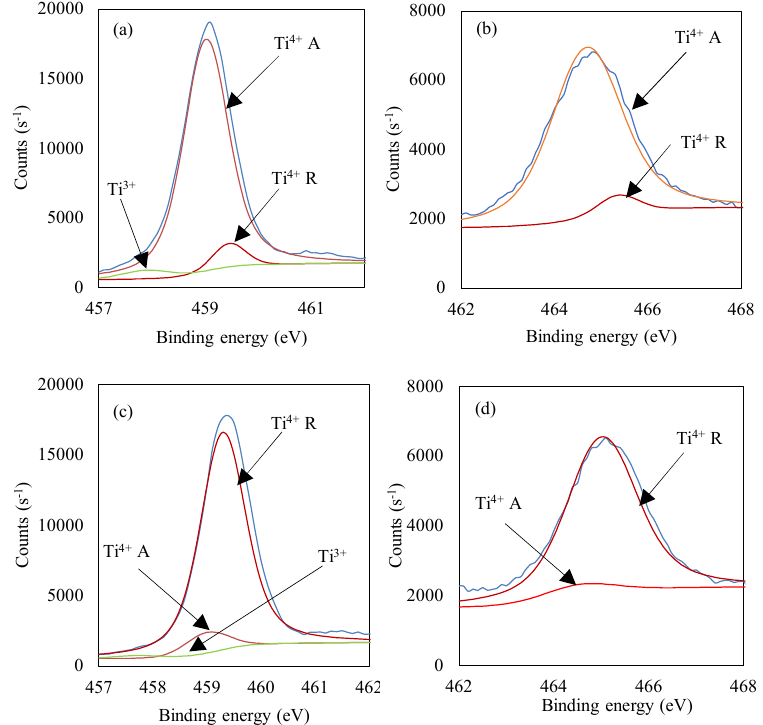
Figure 11. Deconvolution of X-ray photoelectron spectroscopy (XPS) spectra for Ti 2p 3/2 and 2p 1/2 for TBT-HIO 3 _20 (a,b) and TBT-HIO 3 _100 (c,d).